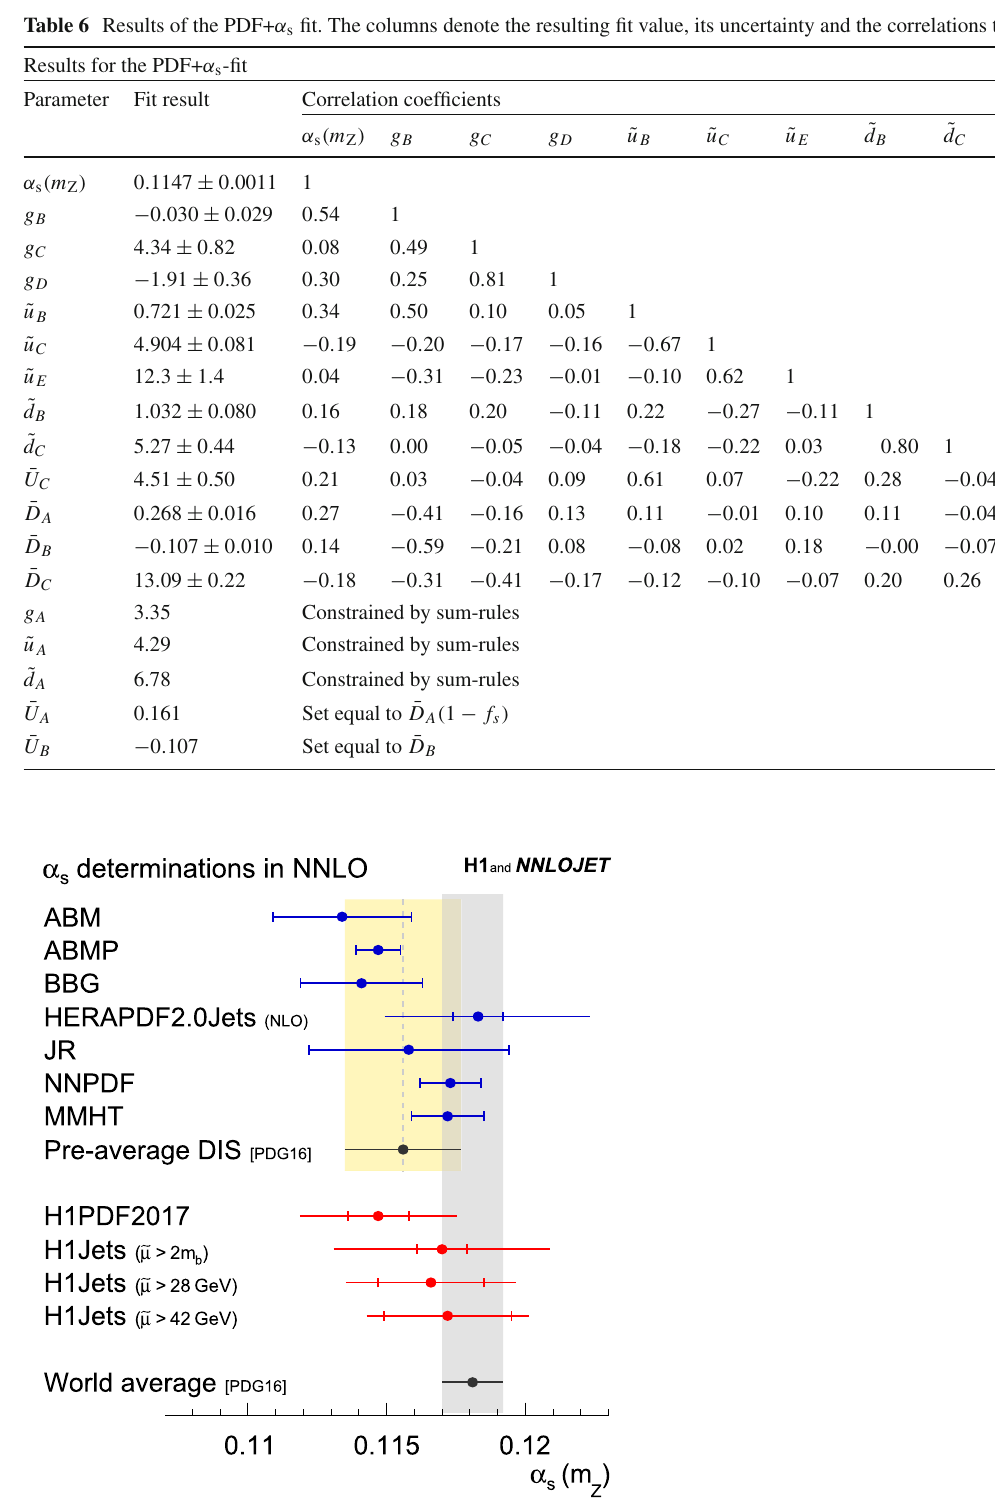
Fig. 15 Comparison of the value of α s ( m Z ) obtained in the H1PDF2017[NNLO] PDF+ α s -fit and in the H1 jets fit in NNLO accu- racytoother α s determinationsfromDISdata.Thepre-averageofstruc- ture function data and the world average [8] are also